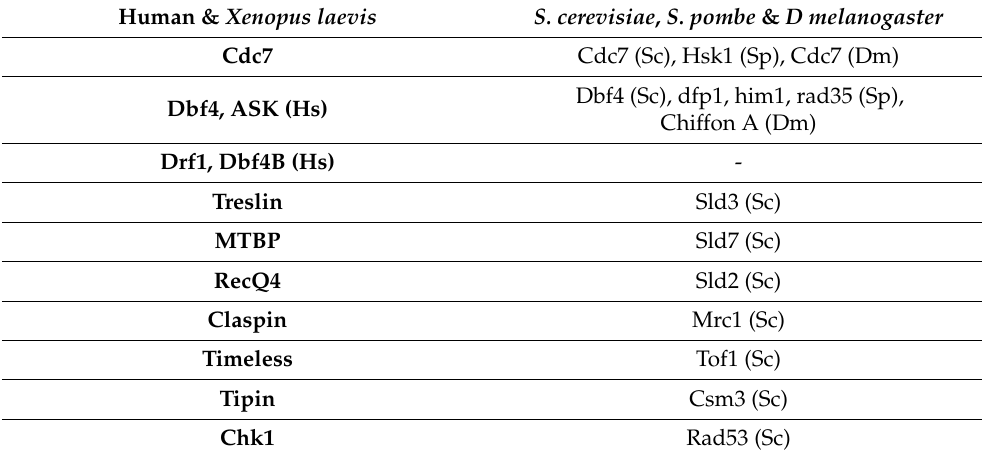
Table 1. Matched nomenclature for protein names in human and Xenopus laevis with those of budding yeast, Saccharomyces cerevisiae , fission yeast, Schizosaccharomyces pombe and fruit fly, Drosophila melanogaster